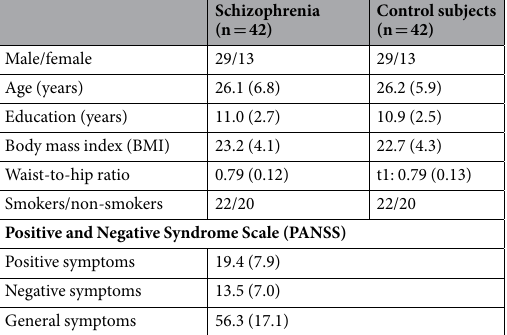
Table 1. Demographic and clinical characteristics of the participants. Data are mean (standard deviations) except for male/female and smokers/non-smokers ratios. There were no significant differences between schizophrenia patients and control subjects as revealed by t-tests (for means/SD) and chi-square tests (for distributions) (p >